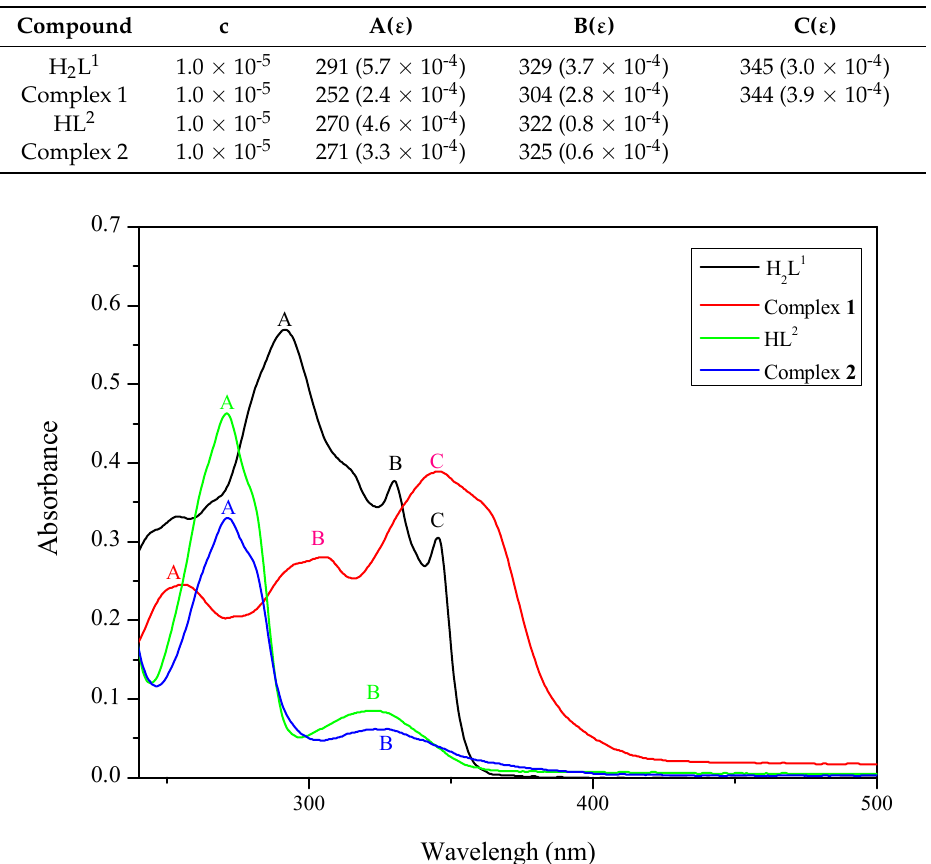
Figure 7. The UV-VIS spectra of the free ligands H 2 L 1 and HL 2 with their corresponding complexes 1 and 2 (cm − 1 ) Table 6 Absorption maxima and molar extinction coefficients for complexes 1 and 2 .